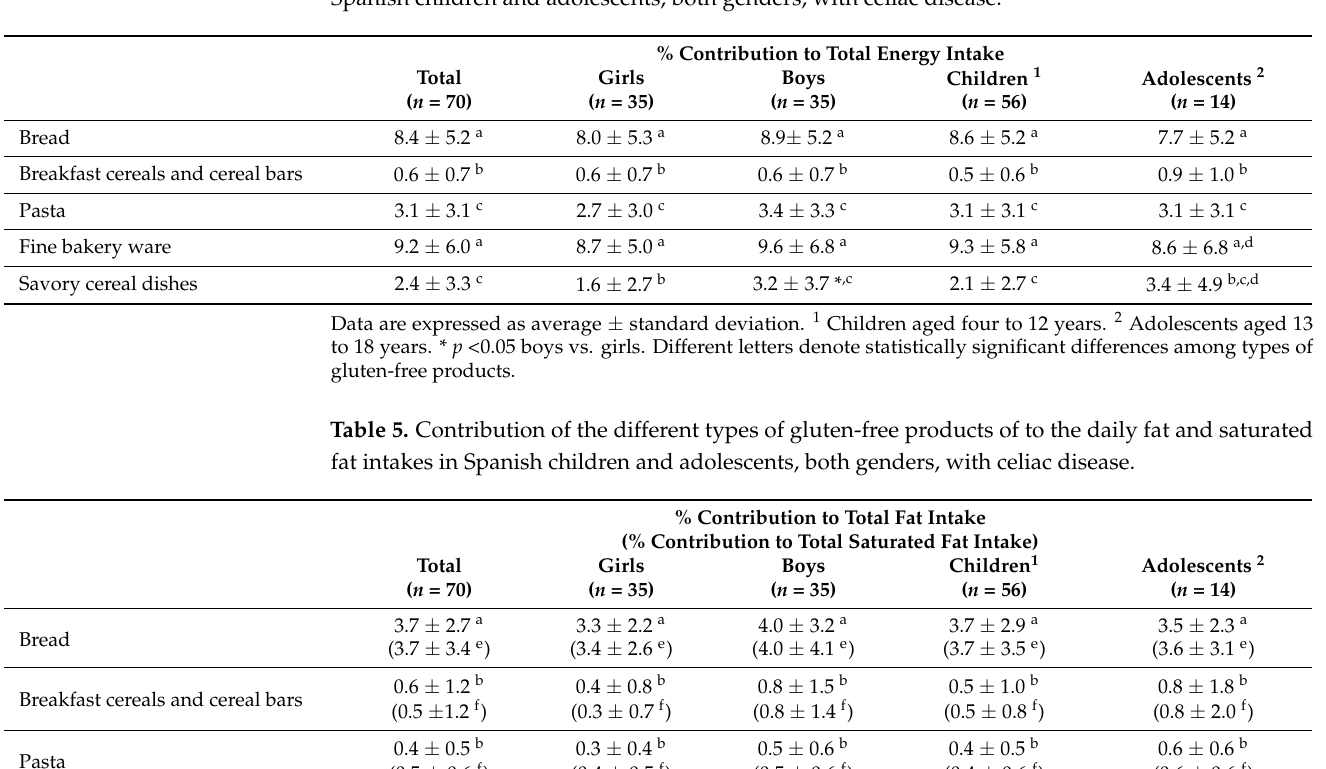
Table 4. Contribution of the different types of gluten-free products of to the daily energy intake in Spanish children and adolescents, both genders, with celiac disease.